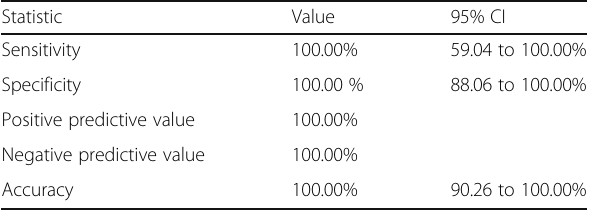
Table 3 Demonstrating the accuracy measures of TAUS in comparison to CT in the detection of the hemidiaphragmatic defects/hernias